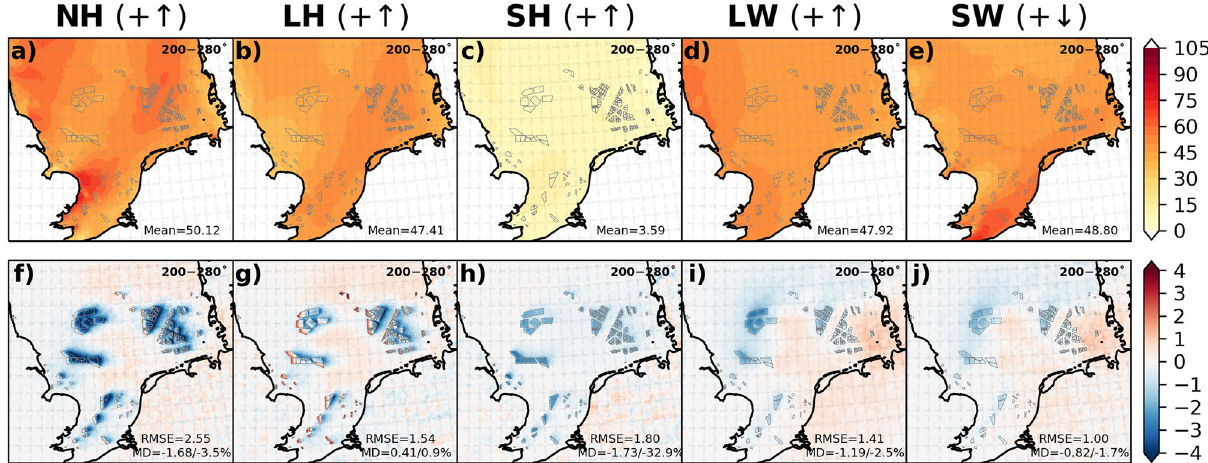
Figure 6. Annual mean values of the CCLM and mean differences between the CCLM_WF and CCLM for ( a , f ) net heat (NH) flux, ( b , g ) latent heat (LH) flux, ( c , h ) sensible heat (SH) flux, ( d , i ) net upwelling longwave (LW), and ( e , j ) net shortwave downwelling (SW) radiations outside and inside the wind farms for the prevailing wind directions of 200–280° in 2008–2017. Root mean square errors (RMSE) and mean differences (MD) over the wind farm areas in 2008–2017 are given in the legend. This figure was created with Matplotlib (Hunter, J. D., Matplotlib: a 2D graphics environment. Computing in Science and Engineering 9, 2007) and Cartopy (Met office, Cartopy: a cartographic python library with a matplotlib interface. Exeter, Devon, https:// scito ols. org. uk/ carto py,